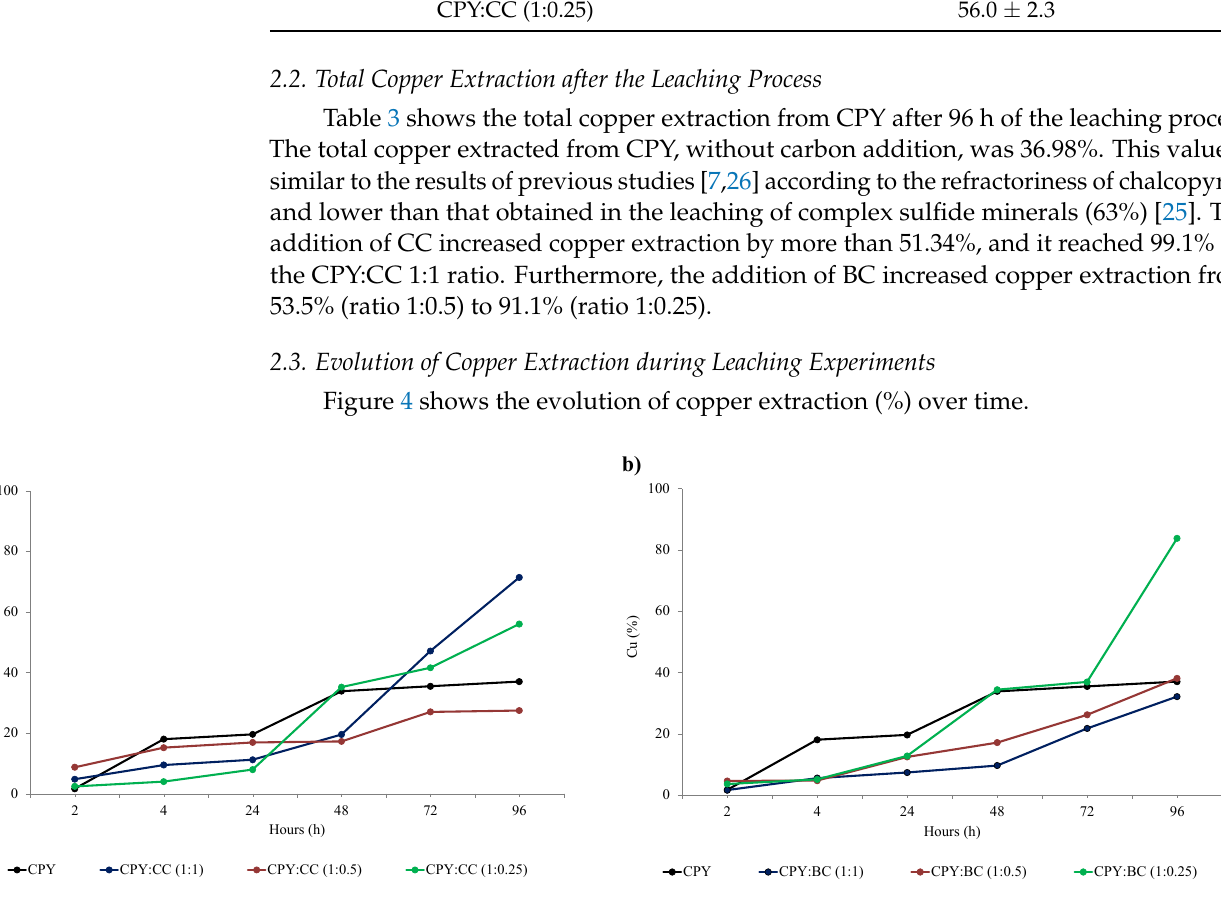
Figure 4. Evolution of copper extraction in the leaching solution: ( a ) CC and ( b ) BC .